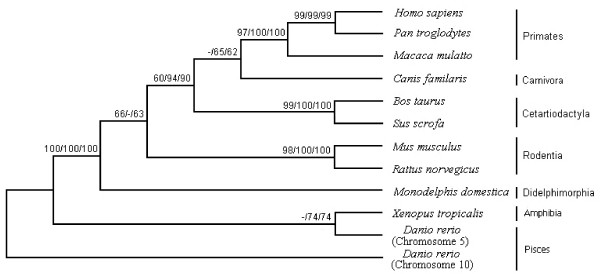
Phylogenetic Tree of 5-exon/4-intron GLTP Gene. Numbers correspond to percentages of bootstrap support for each node from the maximum parsimony, distance, and minimum evolution analyses. (Nucleotide and amino acid sequence alignments are provided as Additional file 1, Figures S4 and S5).